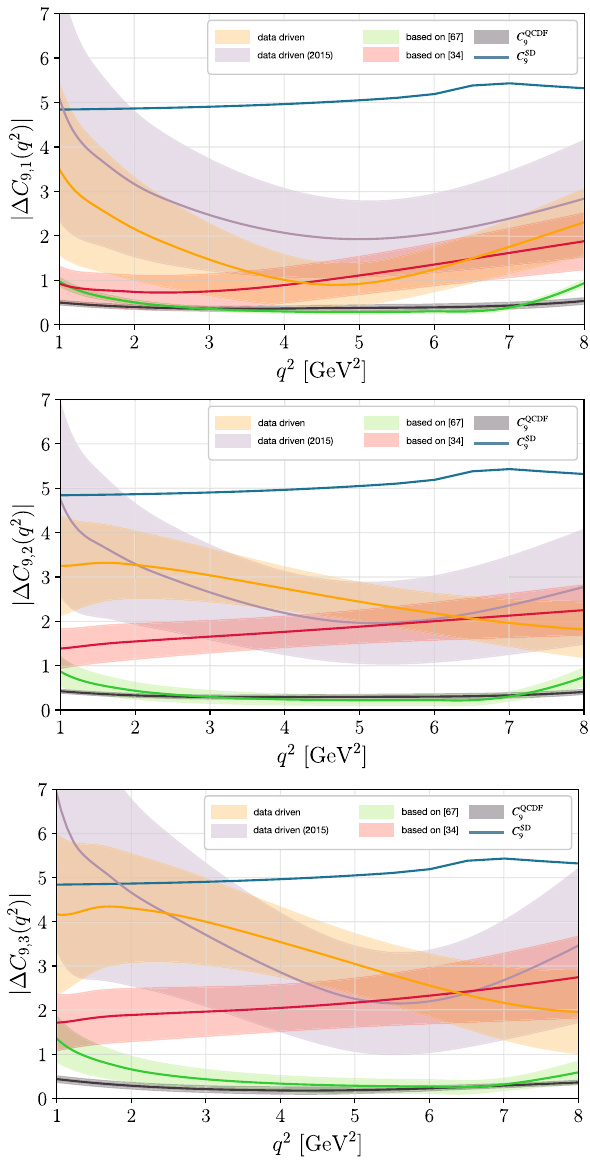
Fig. 3 95% probability contours of the posteriors for the functions Δ C ( q 2 ) defined in Eq. (7) in the three approaches for charming pen- 9 , i guins. For comparison, the result obtained in the data-driven approach with 2015 data is also reported, along with the short-distance